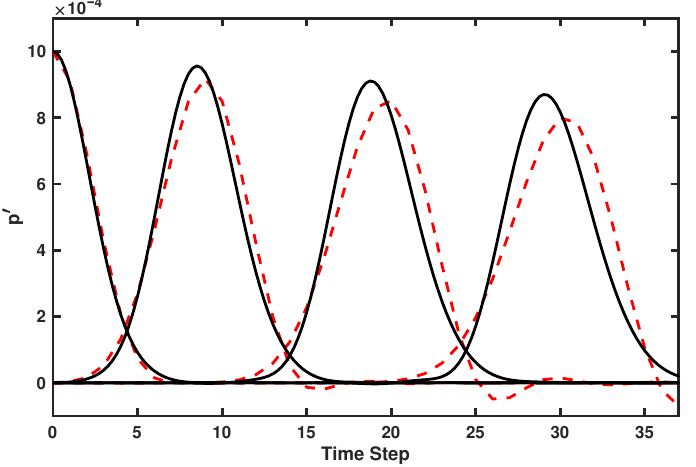
∆ x 2 ∆ t ) with σ = 0.06: